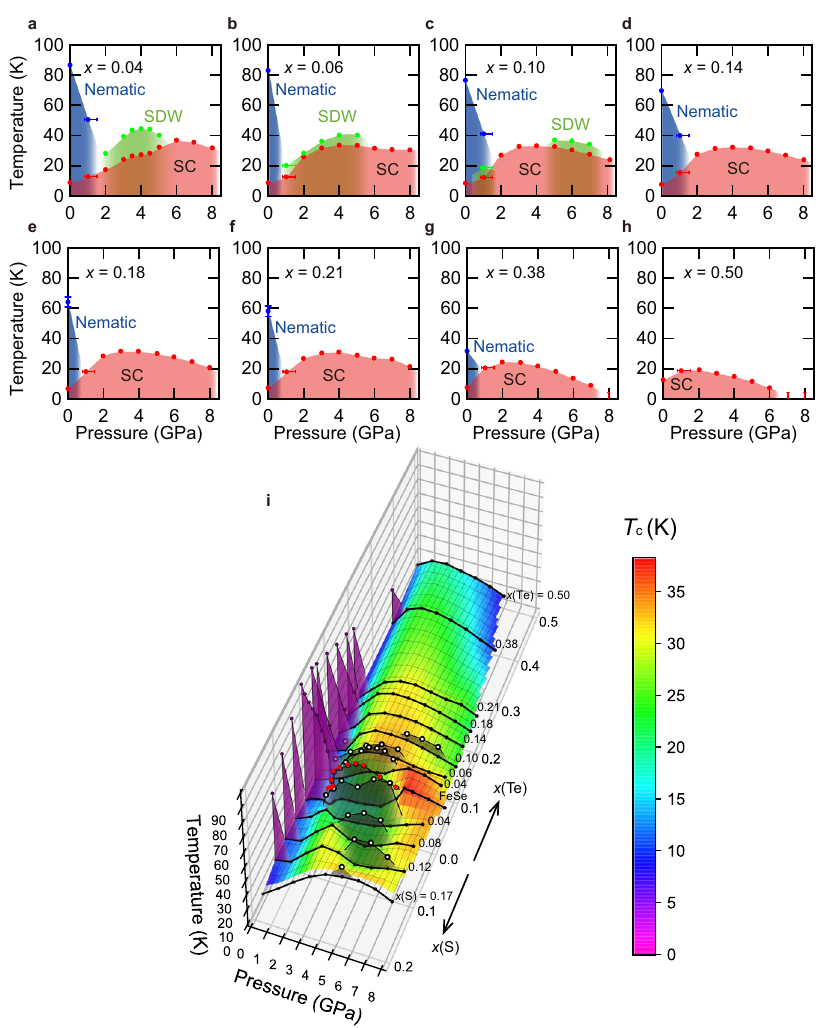
Fig. 4 Temperature – pressure phase diagrams in FeSe 1 − x Te x . Pressure dependence of T c , T s , and T m indicated by red, blue, and green circles, respectively, for x (Te) ≈ 0.04 ( a ), 0.06 ( b ), 0.10 ( c ), 0.14 ( d ), 0.18 ( e ), 0.21 ( f ), 0.38 ( g ), and 0.50 ( h ). The color shades for the nematic, spin density wave (SDW), and superconducting (SC) states are the guides to the eyes. The error of pressure for P < 2 GPa is relatively large (see error bars for 1 GPa) compared to higher pressures. The errors of T s are estimated from the least squares fi t in Fig. 2a. i Three-dimensional electronic phase diagram, temperature versus pressure and Te concentration x (Te), of FeSe 1 − x Te x , combined with the reported T – P – x (S) phase diagram of FeSe 1 − x S x (0 ≤ x (S) ≲ 0.17) 22 . The surface plot shows T c and the purple and white circles represent T s and T m , respectively. The red circles represent T m of FeSe. The gray and purple shadowed areas indicate the magnetic and nematic